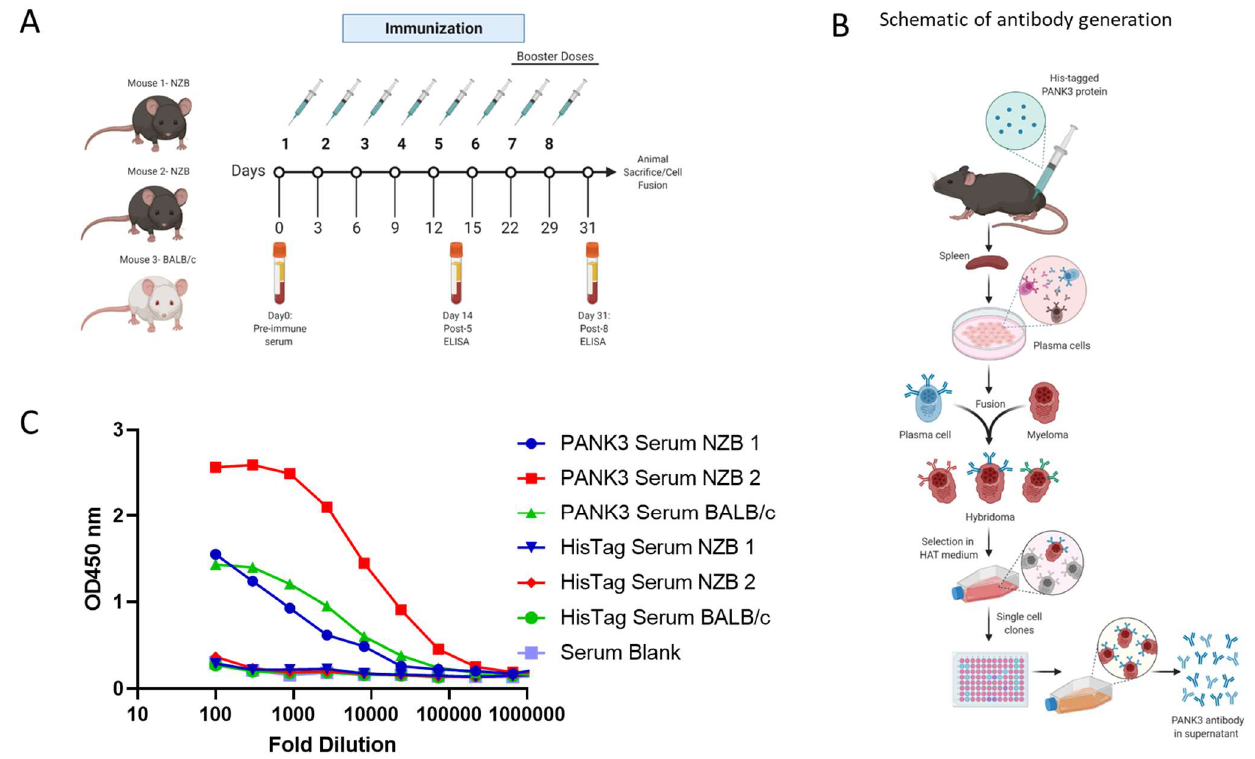
Figure 3. Generation of PANK3 antibody and detection of serum antibody levels by ELISA. ( A ) Schematic showing the schedule of PANK3 protein immunization and blood collection for ELISA. PANK3 was administered into the foot pad of three mice—two NZB mice and a BALB/c mouse—every two days for the first five doses and then weekly for three booster doses. Blood was collected on Days 0, 14, and 31 to determine the antibody concentration in the serum by ELISA. ( B ) Schematic depicting the general workflow for the generation of PANK3 antibody. Briefly, recombinant 20 µL human PANK3 protein and IFA mix was injected into the foot pad of three mice (two NZB and one BALB/c). Following eight injections, mice were euthanized and plasma cells from the spleen were isolated and were fused with murine myeloma cells, Sp20, to form fusion hybridoma cells. After selection in HAT medium, the antibody-producing plasma cells were single-cell cloned and media supernatant from each clone was subjected to ELISA screening. ( C ) Serum titration of anti-PANK3 antibody, collected before mice sacrifice on Day 31, was done using ELISA assay. Serum levels of PANK3 antibody was higher in mouse #2, which was used for subsequent hybridoma generation, single clone isolation, and antibody production. Serum response to His tag is compared to a blank.